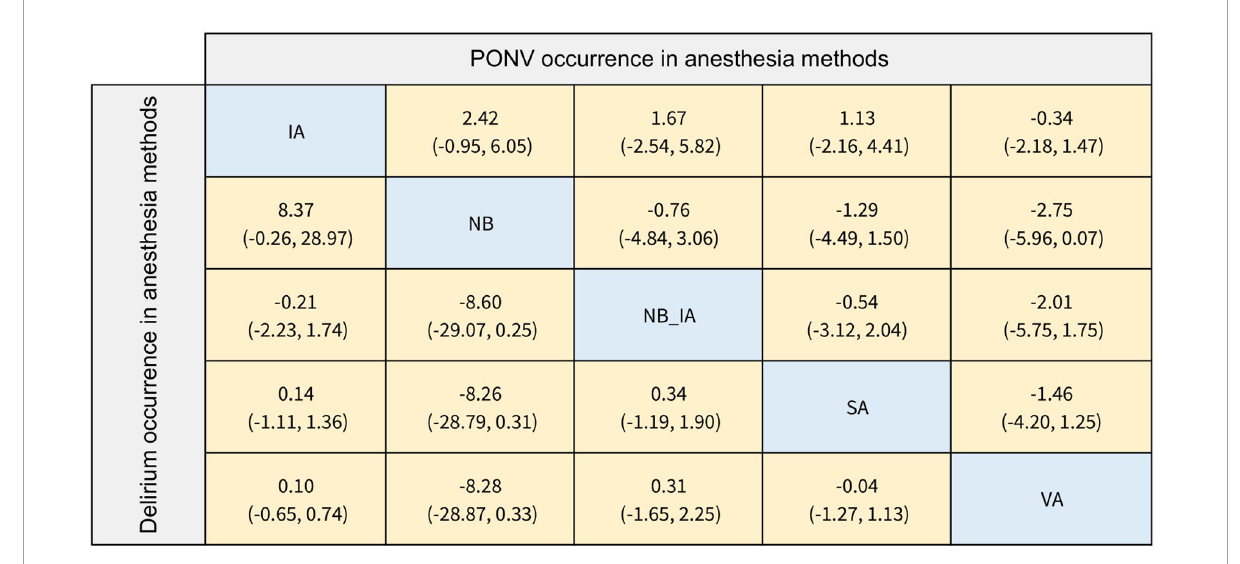
FIGURE4 The league table of delirium and PONV occurrence in anesthesia methods (Data are expressed as Log OR, 95%CI).